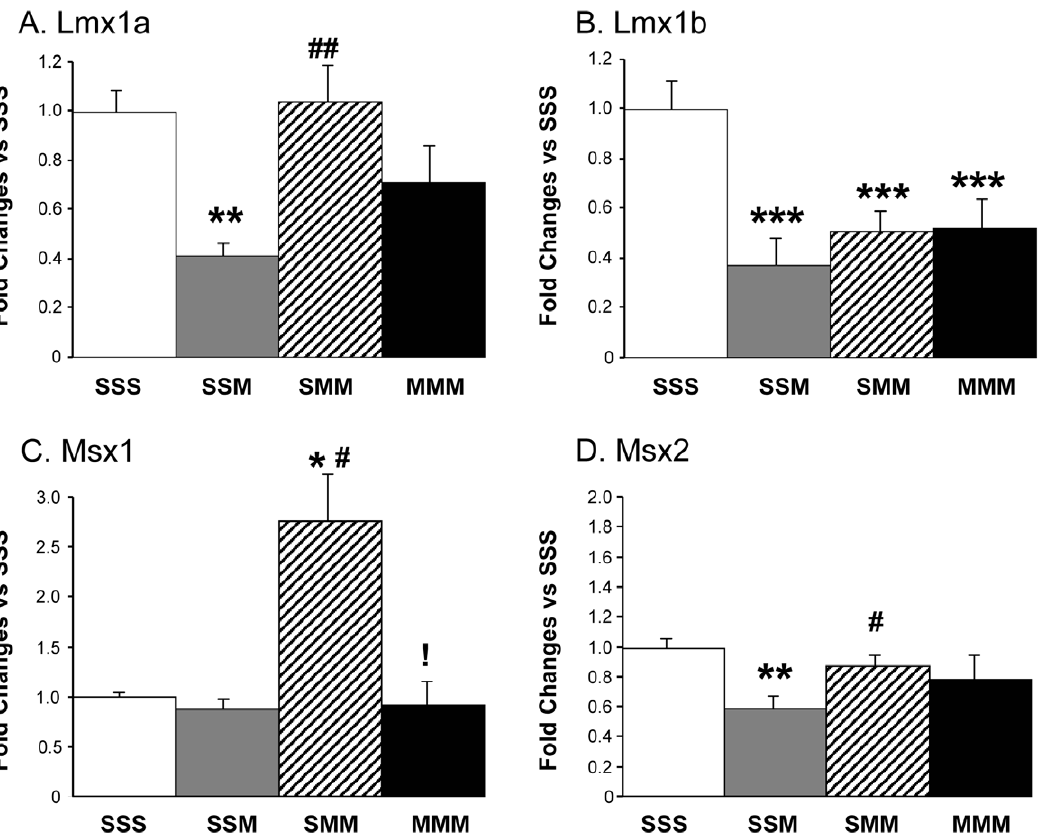
Figure 6. METH treatment induced different changes in Lmx and Msx gene expression in midbrain. METH injections caused significant decreases in Lmx1a expression only in the SSM group (A) but resulted in reductions in Lmx1b mRNA levels in all groups independent of pretreatment (B). There were increases in Msx1 expression only in the saline-pretreated group challenged twice with METH (C). In contrast, METH caused decreases in Msx2 expression in the SSM group (D). The values represent means 6 SEM in comparison to the saline-pretreated challenged with saline group (SSS). N=5–6 animals per group. Keys to statistics are as described in Fig. 4.